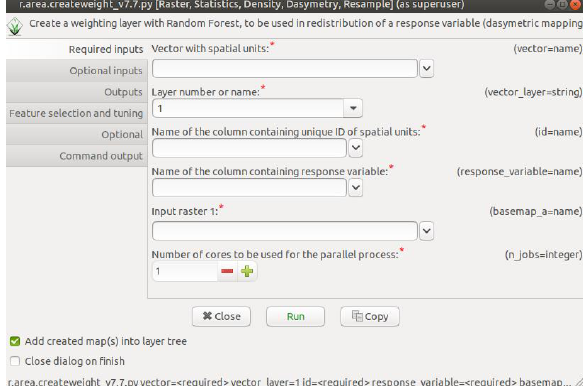
Figure 1 . Proposed layout of the “r.area.createweight” add-on in GRASS GIS